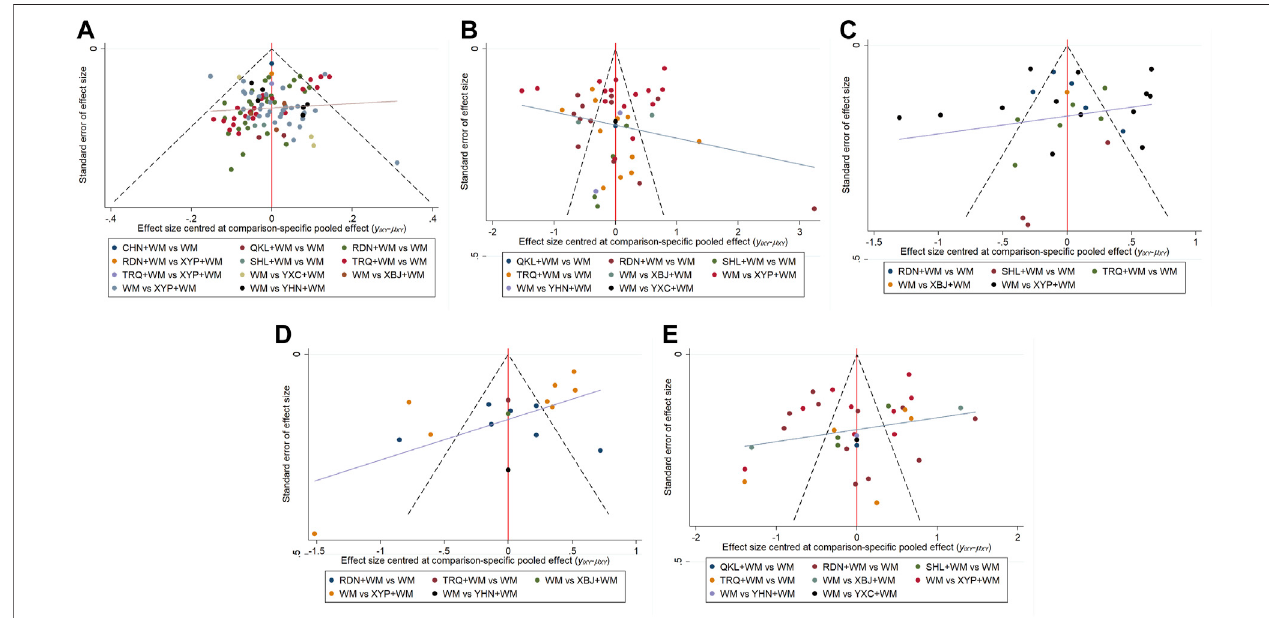
FIGURE 5 | Funnel plots (A) Clinical effectiveness rate (B) Antipyretic time (C) Sore throat relief time (D) Red and swollen tonsils relief time (E) Tonsillar exudate relief time.